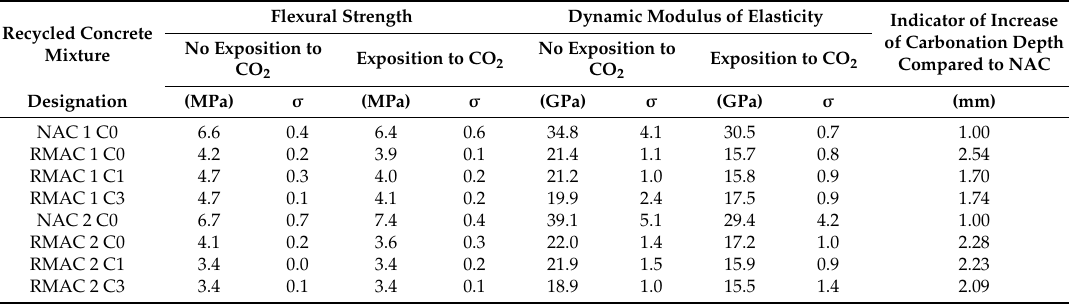
Figure 8. Carbonation depth of NAC and RMAC. Table 7. Flexural strength, dynamic modulus of elasticity and carbonation depth after 28 days in laboratory incubator with air circulation with CO 2